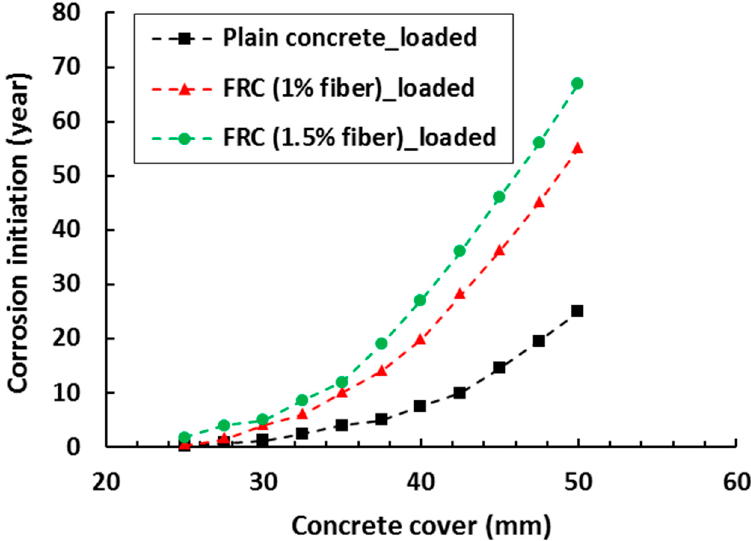
Figure 8. Predicted corrosion initiation of FRC and plain concrete at varying cover depth (adapted from [128] ).